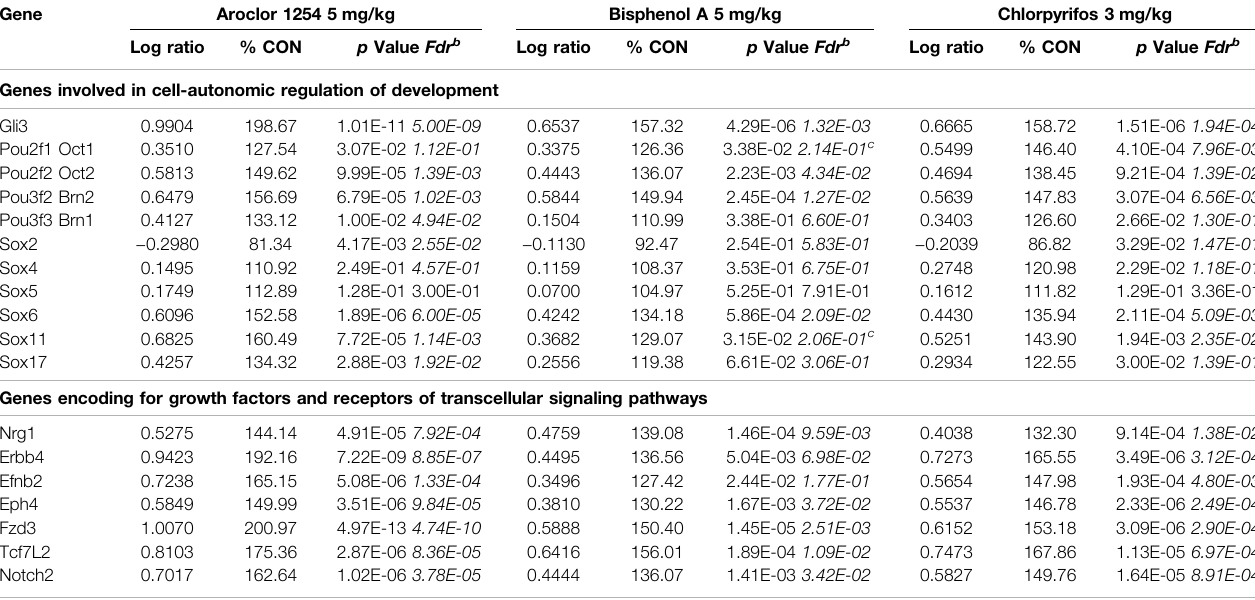
TABLE 4 | Male hippocampus at postnatal day 6: Expression of similarly affected genes (transcriptomics) a . Gene Aroclor 1254 5 mg/kg Bisphenol A 5 mg/kg Chlorpyrifos 3 mg/kg Log ratio % CON Log ratio